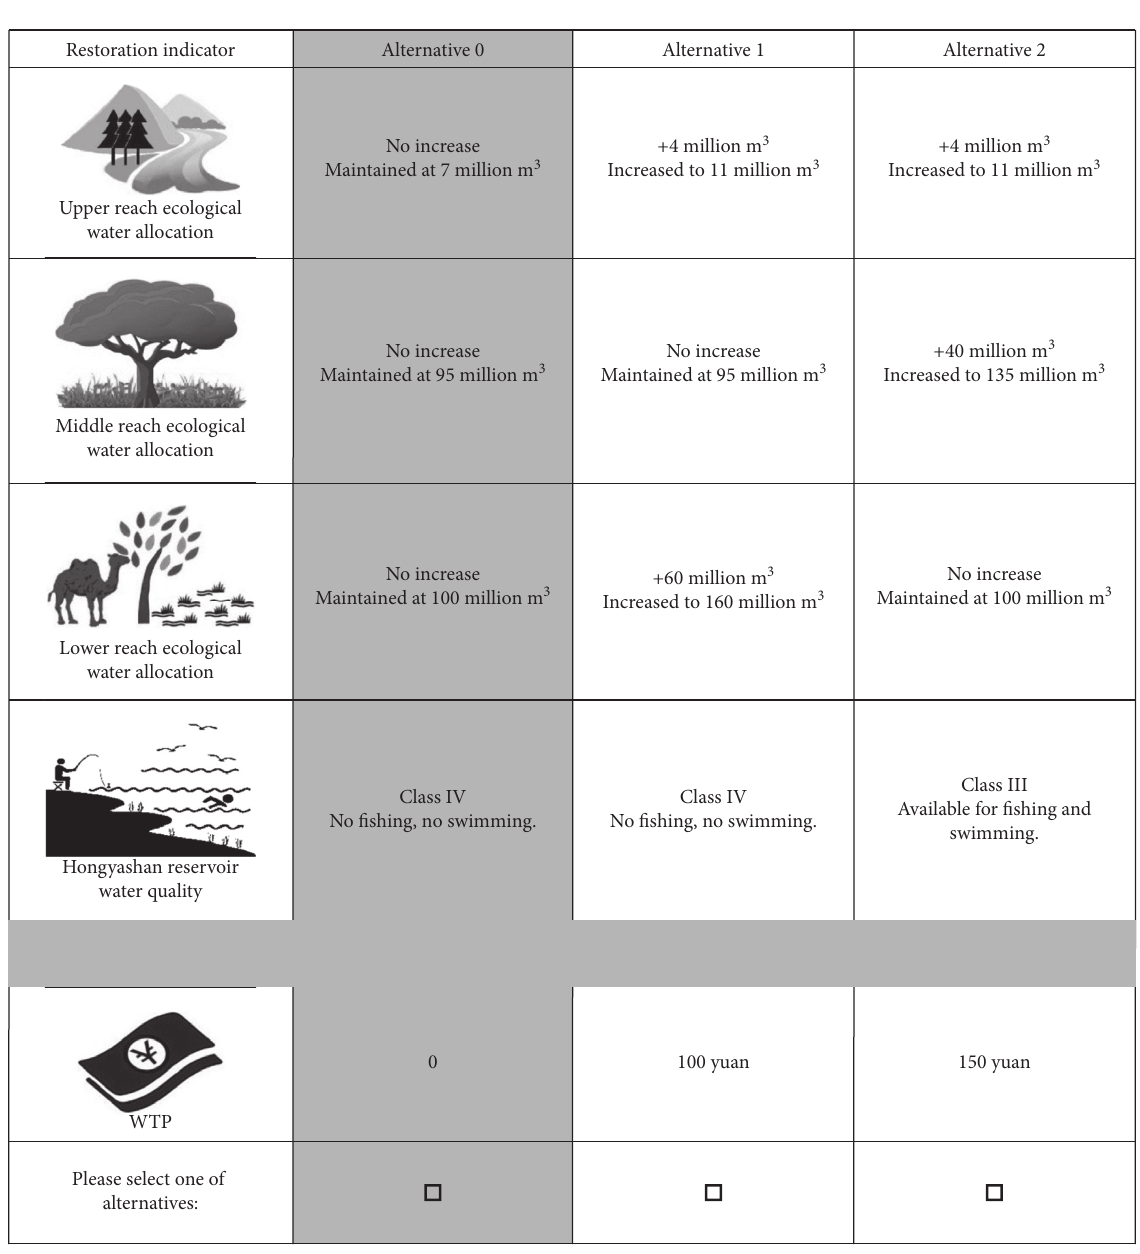
Figure 2: Example of a choice